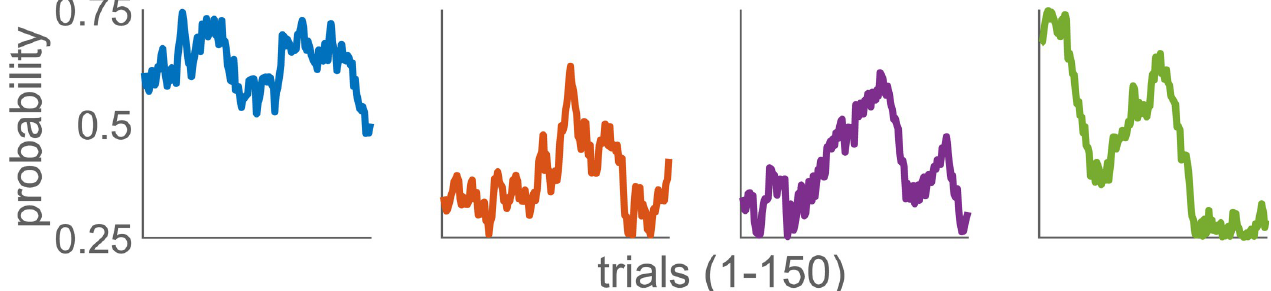
Fig 2. The sample evolution of the reward probability for each of the chest in stage 2. The probabilities (in the order as in Fig 1) evolve over 150 trials, according to a Gaussian random walk with σ = 0.0275. One set of two evolutions always starts randomly in a range [0.58, 0.72], while the other set of two starts in [0.31, 0.45]. The values of probabilities are bounded in [0.25, 0.75].